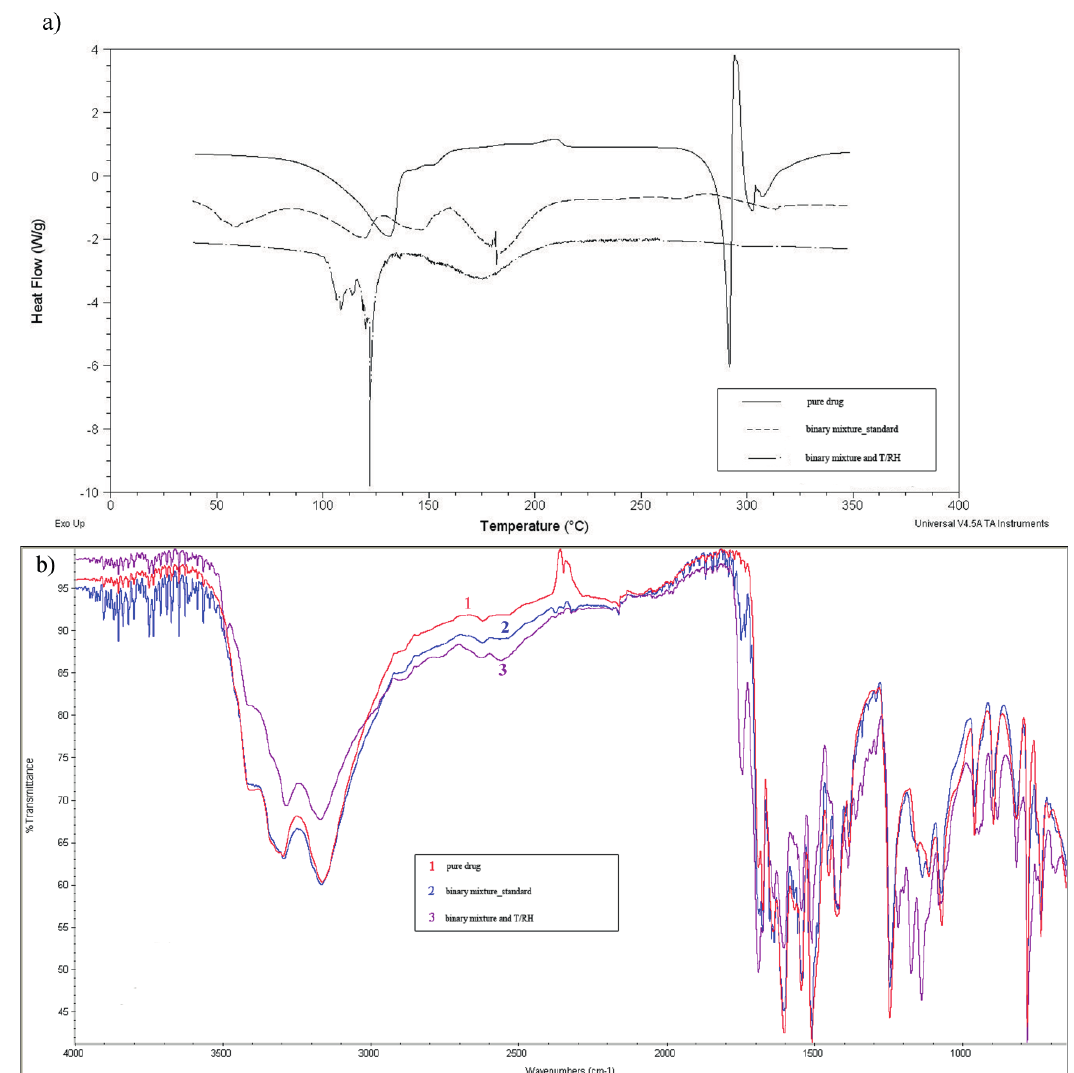
Figure 5 : Amiloride and citric acid: DSC scans (a) and FT-IR spectra (b) for the mixture stressed with high temperature/humidity (T/RH) and the untreated mixture (standard) against pure